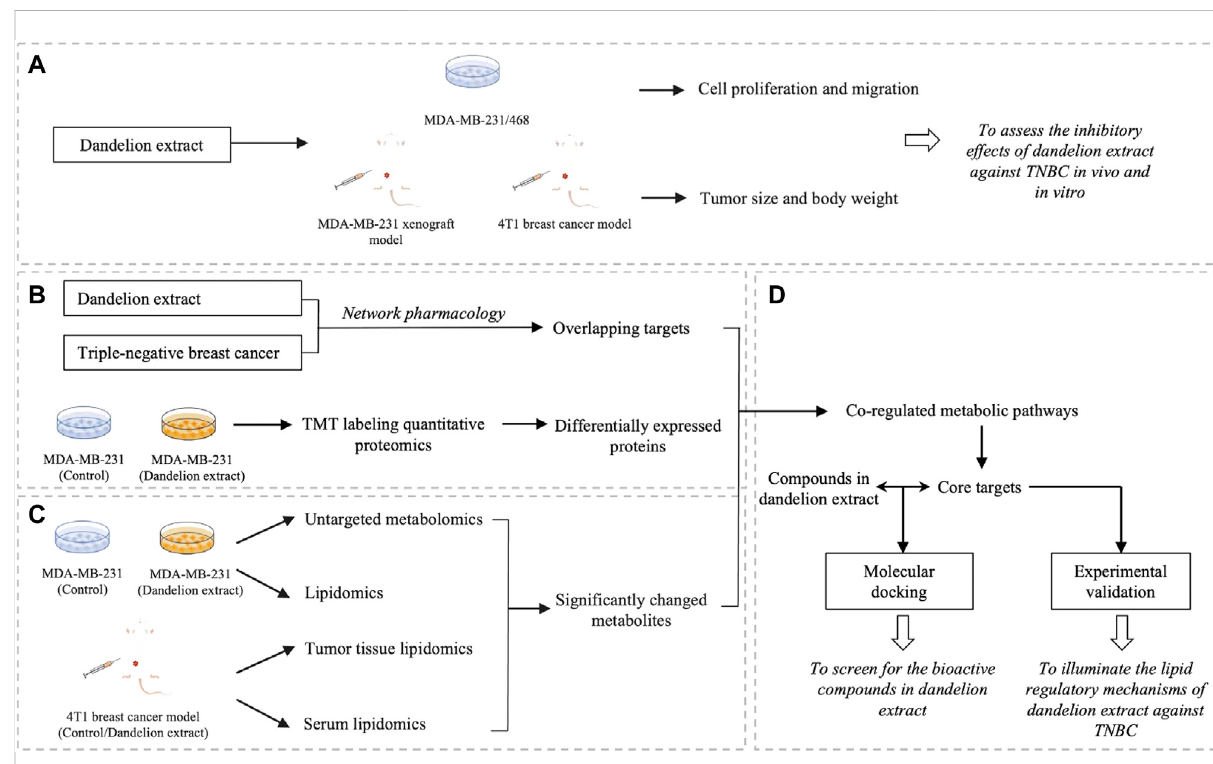
FIGURE 1 The schematic fl owchart of the integrated analysis for dandelion extract against TNBC. (A) The inhibitory effects of dandelion extract against TNBC invivo and invitro . (B) TheNetworkpharmacologyanalysisandquantitative proteomicanalysis. (C) The metabolomicsand lipidomics analysis using the TNBC cell, tumor tissue, and plasmas specimens. (D) The experimental veri fi cation of key targets and the screening for the bioactive compound in dandelion extract via molecular